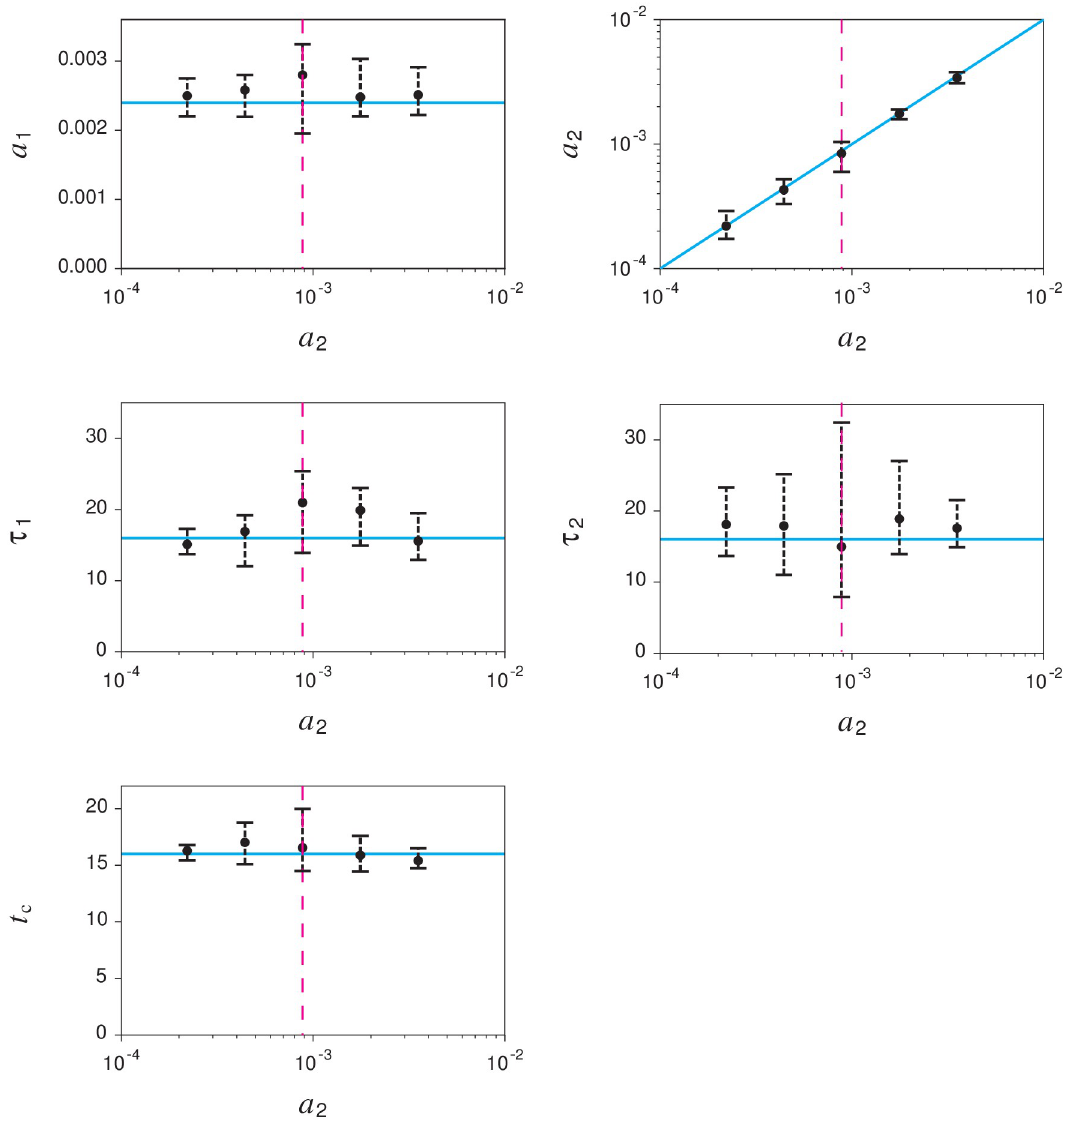
Fig 3. Estimation accuracy of parameters around the non-identifiable domain. Black circles and error bars represent the median and interquartile ranges of the estimates obtained from 100 synthetic data. Dashed magenta lines represent the non-identifiable (cid:0) t c = t 2 . Cyan lines indicate the true value: a 1 = 0.0024, τ 1 = τ 2 = 16, and t domain satisfying a ¼ a 2 1 e 2.2 × 10 − 4 and 3.5 × 10 − 3